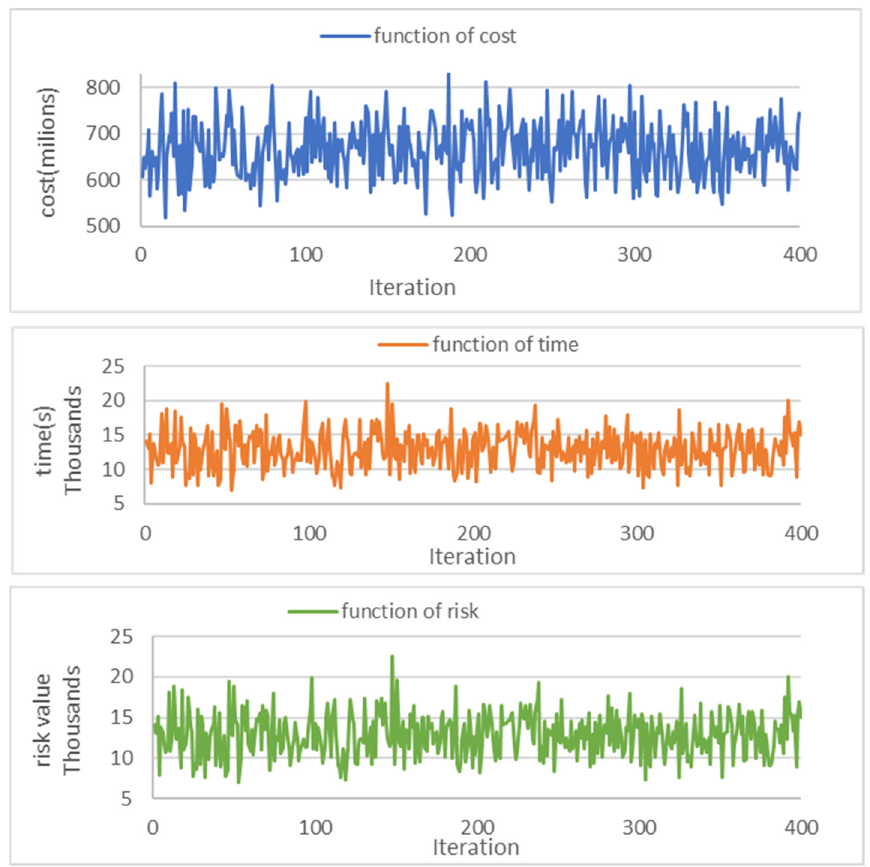
Figure 10. Schematic view of objective functions convergence by iteration.